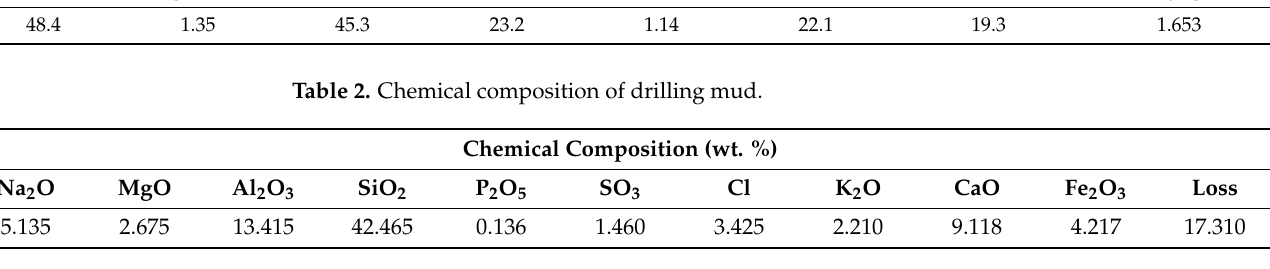
Table 3. Analysis of heavy components of drilling waste mud. Heavy Metal Content (wt.